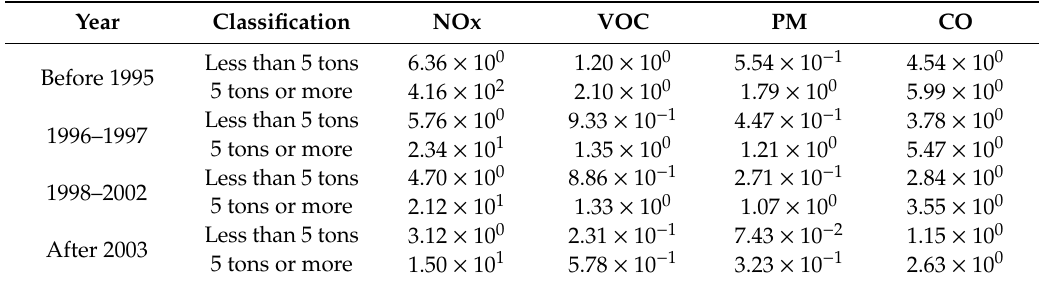
Table 2. The emission factors for each type of commercial vehicles (unit: g / km